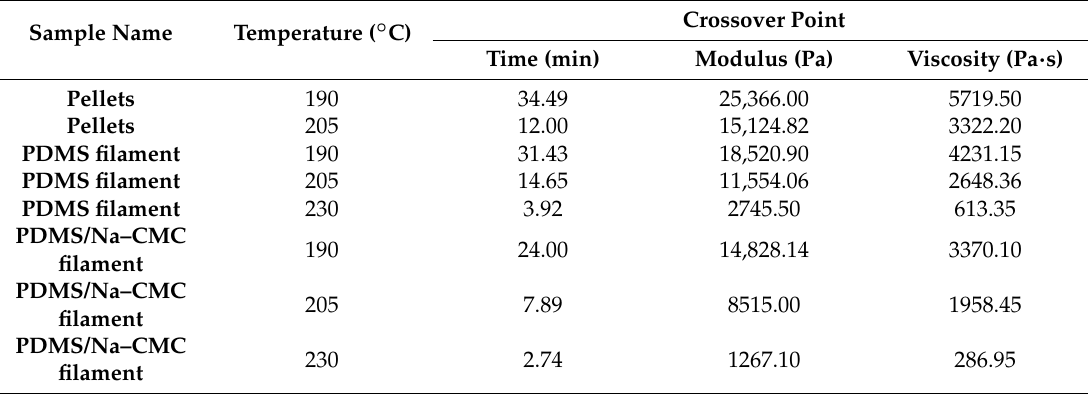
Table 2. Synthesis of the main data obtained from the rheological analysis for PDMS pellets and filament and for Na–CMC-modified PDMS filament. Different gray scale is used to highlight different temperature values.